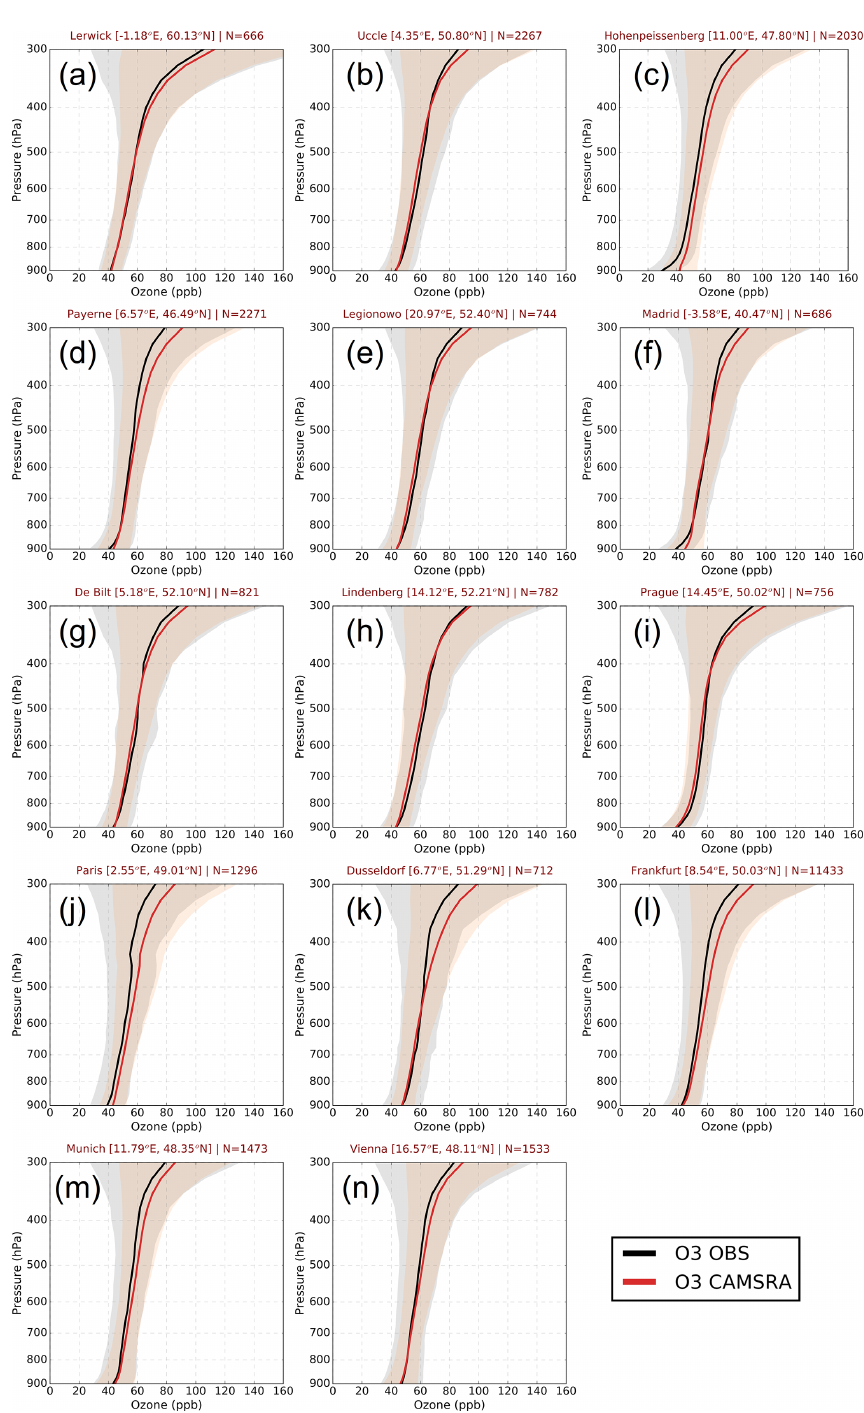
Figure 3. Vertical profiles of observed (black) and CAMSRA (red) ozone concentrations (ppb) at the WOUDC ozonesonde stations of (a) Lerwick (UK), (b) Uccle (Belgium), (c) Hohenpeissenberg (Germany), (d) Payerne (Switzerland), (e) Legionowo (Poland), (f) Madrid (Spain), (g) De Bilt (the Netherlands), (h) Lindenberg (Germany), and (i) Prague (Czech Republic) and at the IAGOS airports of (j) Paris (France), (k) Düsseldorf (Germany), (l) Frankfurt (Germany), (m) Munich (Germany), and (n) Vienna (Austria) for the period 2003–2018. The grey and sandy brown areas depict the ± 1 standard deviation of ozone vertical profiles in observations and CAMSRA, respectively.